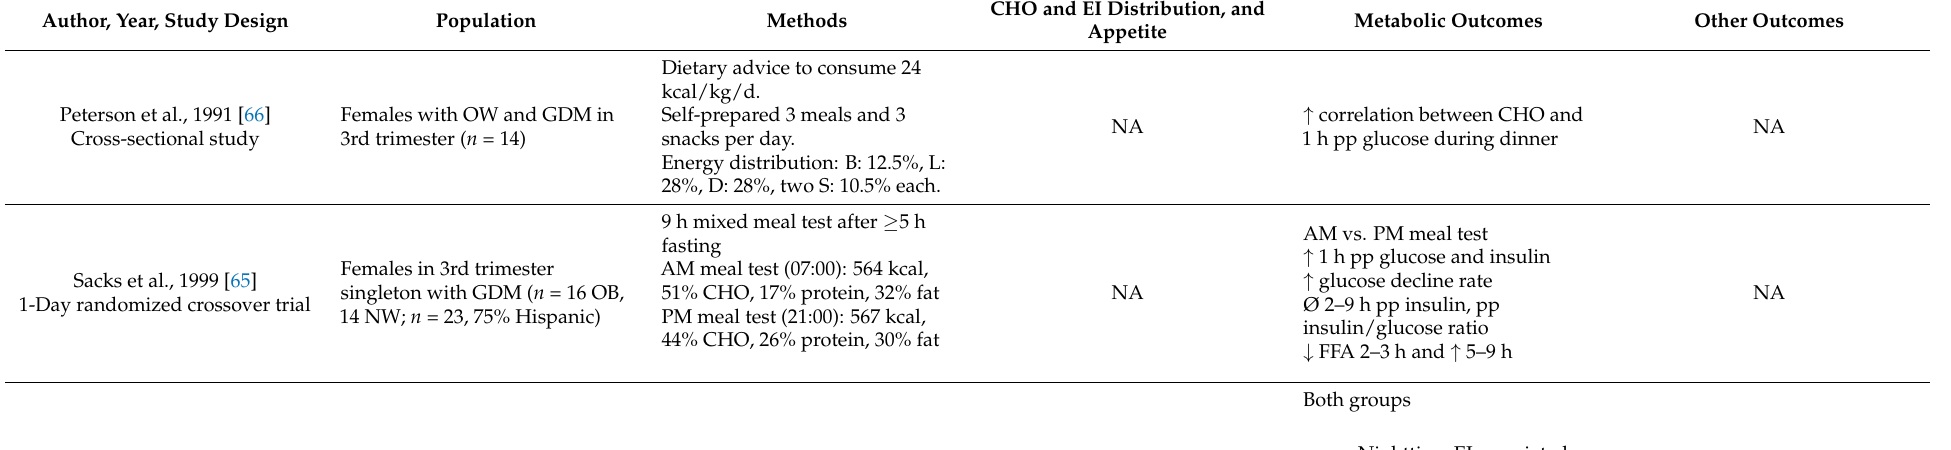
Table 1. Summary table of studies on meal timing and glucose metabolism during